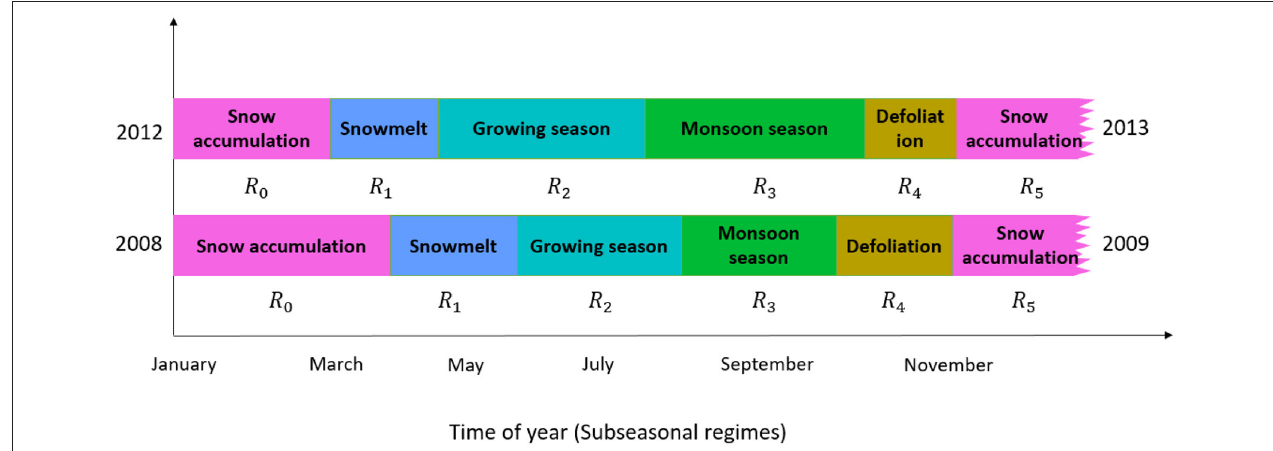
FIGURE 3 | Example subseasonal regimes ( R i ) within a year, which could include snow accumulation, snow melt, growing season, monsoon, and defoliation. X i represents the data used to determine subseasonal regimes and follow a statistical distribution denoted by F ( µ i , σ 2 i ). µ i and σ 2 i are the mean and variance of X i under specific subseasonal regimes,